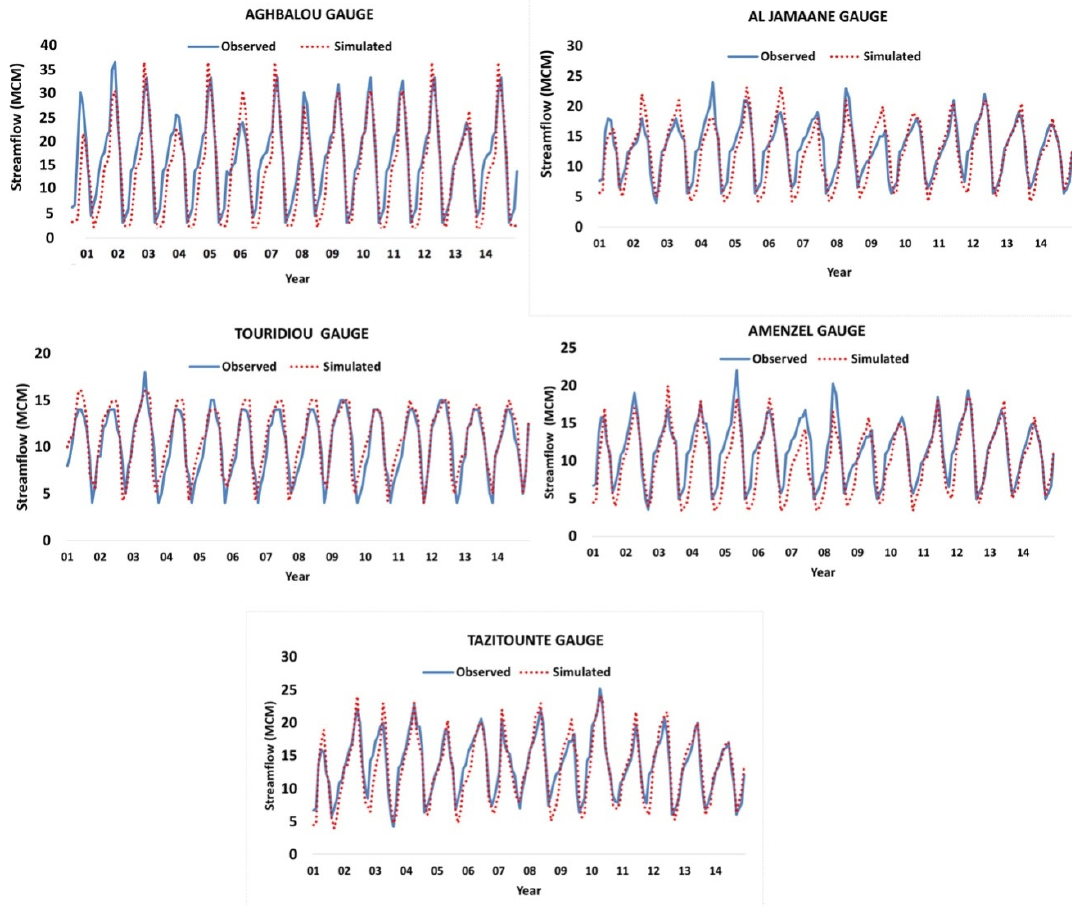
Figure 6. Observed and simulated monthly streamflow for calibration and validation periods of the five-gauge stations obtained from water assessment and planning tool (WEAP) model for the Ourika watershed.